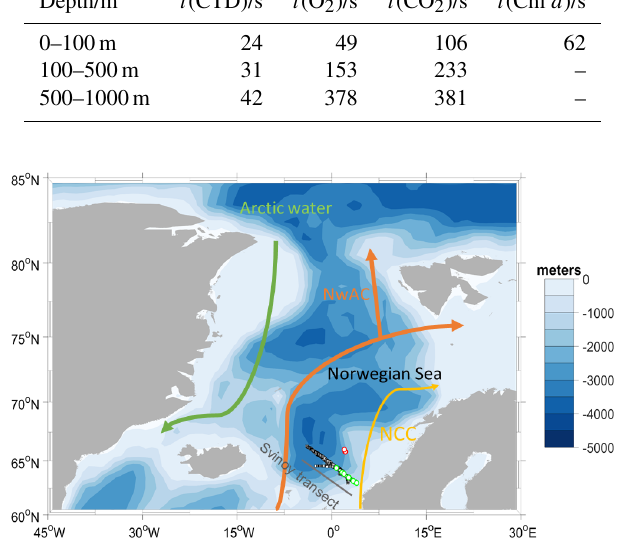
Figure 1. Map of the glider deployment and the main currents. The black dots are the glider dives; the green and the red dots are the water samples collected along the glider section and at Ocean Weather Station M (OWSM), respectively. The three main water masses (Skjelvan et al., 2008) are the Norwegian Coastal Current (yellow), the Norwegian Atlantic Current (NwAC, orange) and Arc- tic Water